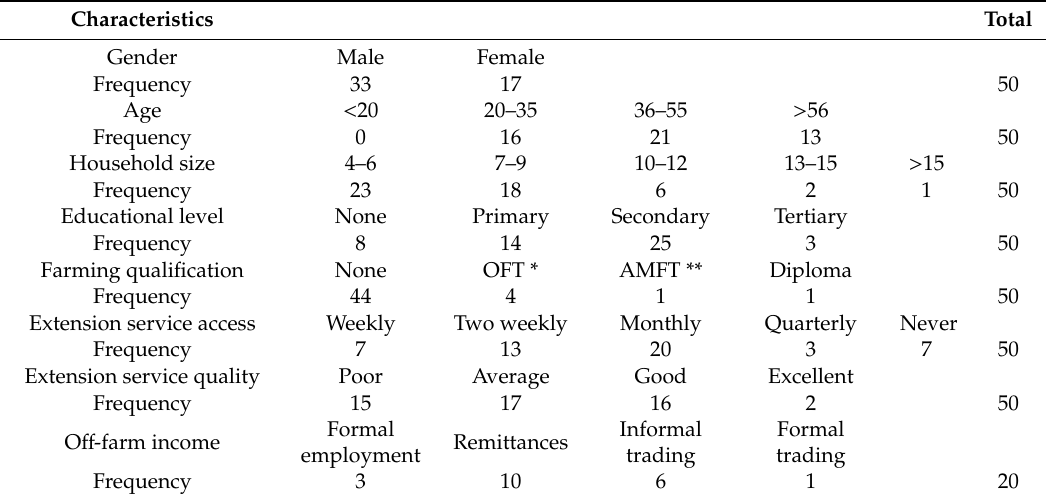
Table 2. Socioeconomic characteristics of respondents.